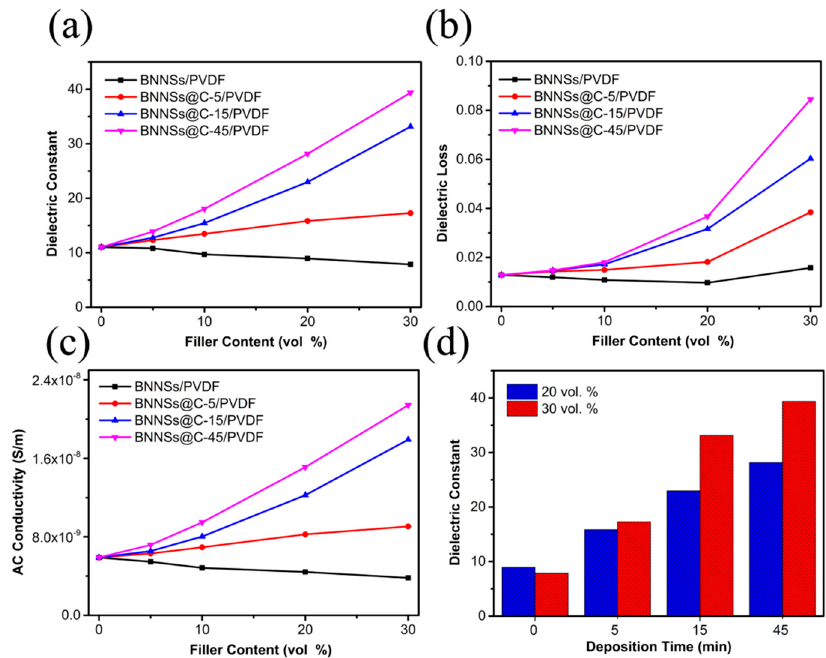
Figure 6. Dependence of the ( a ) dielectric constant; ( b ) dielectric loss; and ( c ) ac conductivity values of BNNSs/PVDF, BNNSs@C-5/PVDF, BNNSs@C-15/PVDF, and BNNSs@C-45/PVDF nanocomposites on the filler loadings (10 3 Hz); ( d ) Typical variation of dielectric constant values (10 3 Hz) of